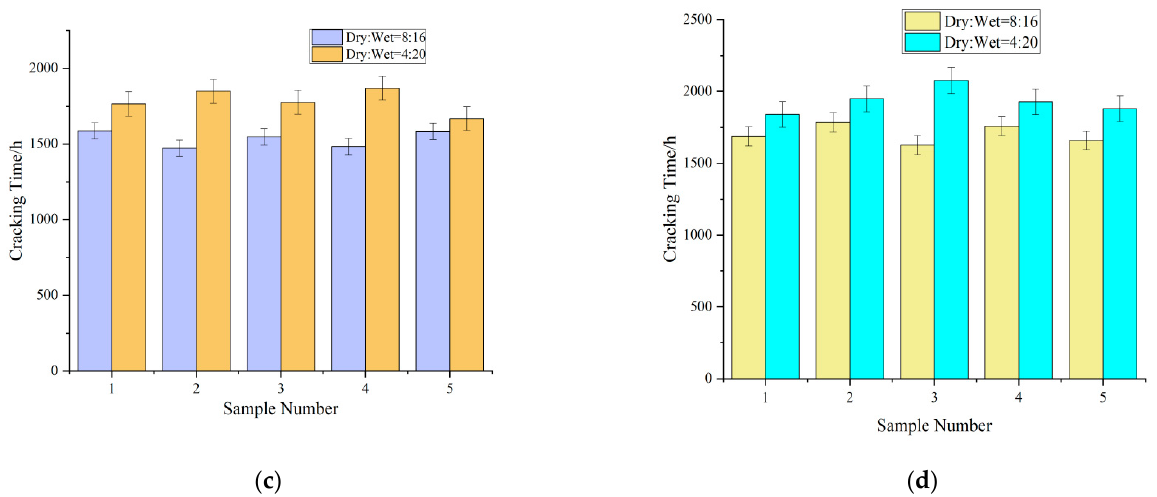
Figure 7. Effect of drying–wetting cycles on cracking time of the specimens. ( a ) Cracking time of specimens in different drying–wetting cycles ( l = 32 mm, d = 8 mm); ( b ) cracking time of specimens in different drying–wetting cycles ( l = 32 mm, d = 10 mm); ( c ) cracking times of specimens in different drying–wetting cycles ( l = 40 mm, d = 8 mm); ( d ) cracking times of specimens in different drying–wetting cycles ( l = 40 mm, d = 10 mm).